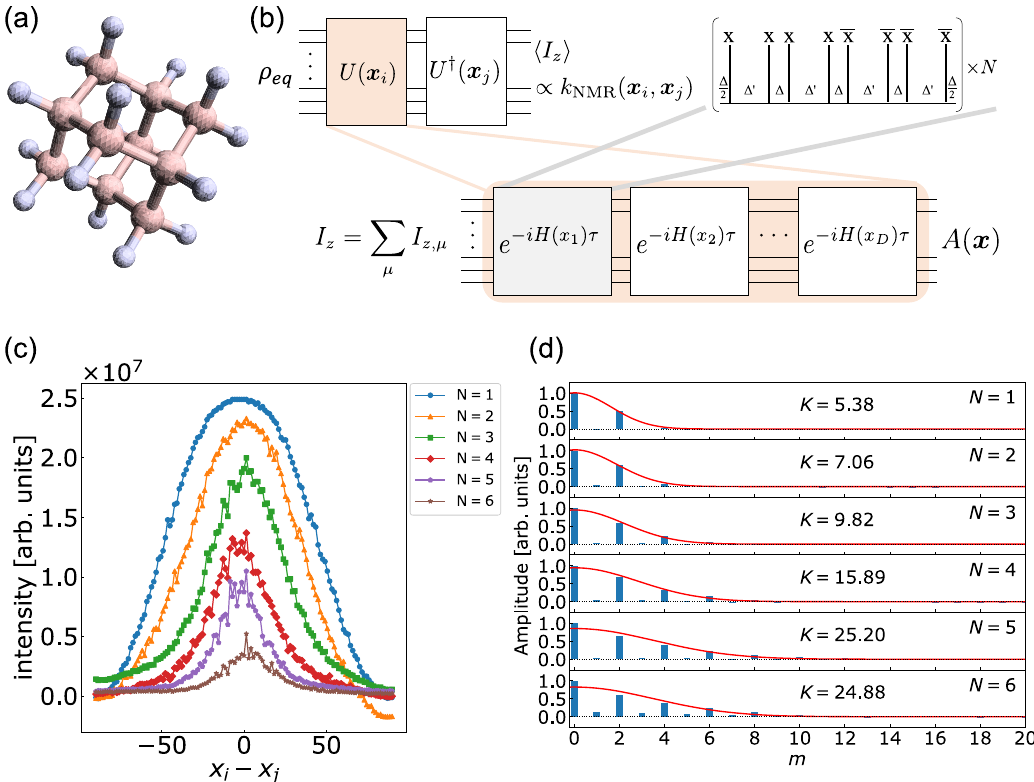
Fig. 1 Experimental setups. a Adamantane molecule. The white and pink balls represent hydrogen and carbon atoms, respectively. b Quantum circuit and pulse sequence employed in this work to realize evaluation of k NMR ( x i , x j ). The top right shows a pulse sequence for x 1 = 0, where X and X represent + π /2 and − π /2 pulses along x -axis, respectively. In the experiment, Δ and Δ 0 are set 3.5 μ s and 8.5 μ s, respectively. c NMR kernel employed in this work. d Fourier transform of ( c ) which corresponds to the obtained 1 H multiple-quantum spectra for N = 1 to N = 6. Red line is Gaussian a exp ð(cid:4) m 2 = K Þ fi tted to the spectra using a and K as fi tting parameters. The Gaussian is fi tted only to even m data points. K is the cluster size of the system 18,30,33